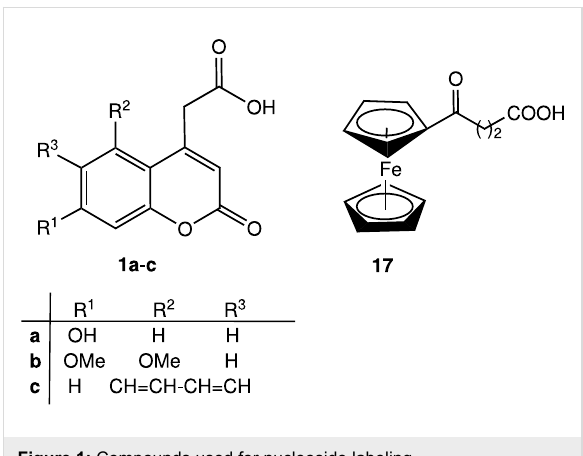
Figure 1: Compounds used for nucleoside